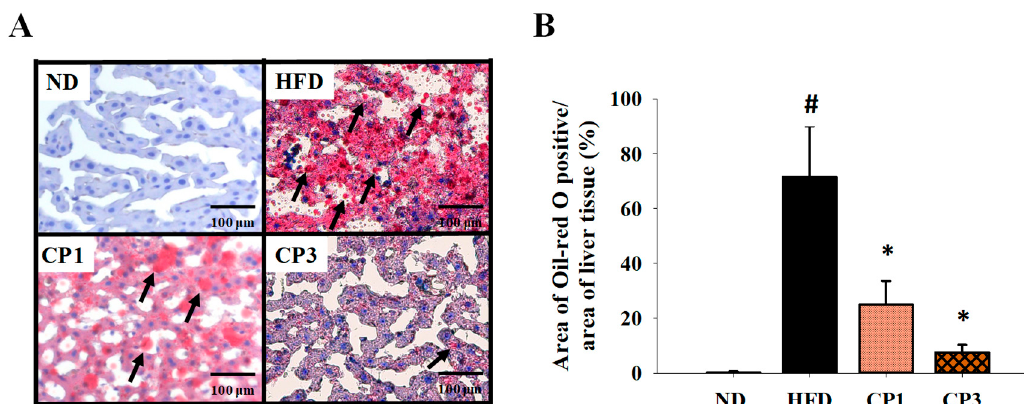
Figure 5. Histopathological analysis of liver tissue stained with oil red O. After 16-week treatment, the rats were sacrificed, and the liver samples were isolated to prepare paraffin-embedded sections for oil red O staining. ( A ) Representative photos are shown. Scale bar = 100 μ m. Arrows indicate lipid droplets. ( B ) The percentage of oil red O positive area in the area of liver tissue was calculated by ImageJ image processing and analysis program. Results are expressed as mean ± S.D. for each group of rats ( n = 6). # p < 0.05 compared with the ND group; * p < 0.05 compared with the HFD group.